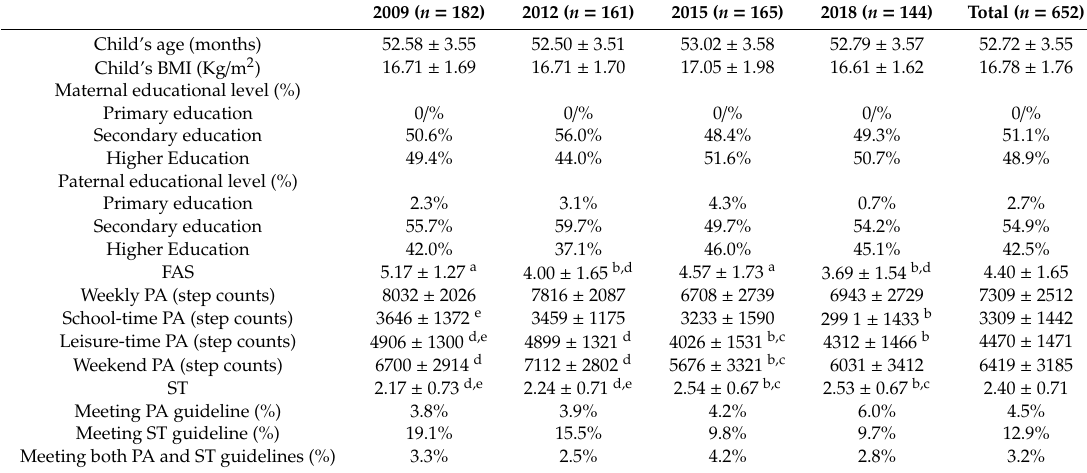
Table 1. Descriptive statistics for participants by